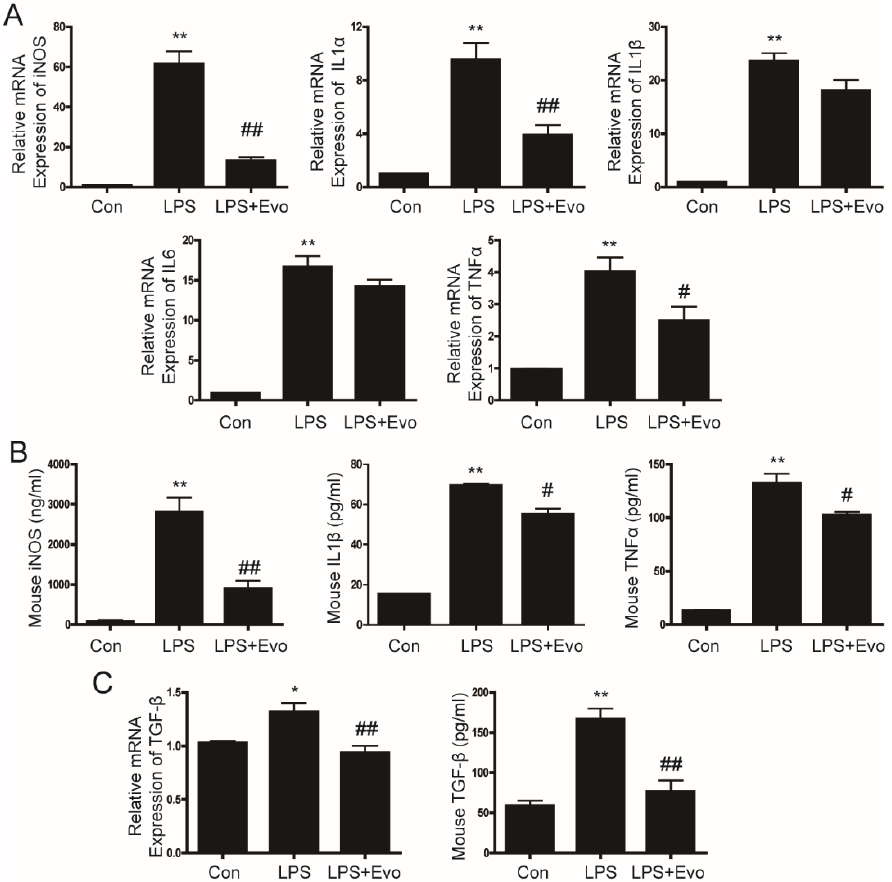
Figure 2. The inhibitory effect of evogliptin on LPS-induced cytokine levels in hepatocytes. Primary hepatocytes were pretreated with LPS for 2 h and then treated with evogliptin for 24 h. ( A ) Repre- sentative real-time RT-PCR analysis of the expression levels of iNOS, IL1 α , IL1 β , IL6, and TNF α . Data are the mean ± SEM. ** p < 0.01 relative to the control, ## p < 0.01 relative to the LPS. ( B ) The production of iNOS and the secretion of IL1 β and TNF α were measured using ELISA. Data are the mean ± SEM. ** p < 0.01 relative to the control, # p < 0.05, ## p < 0.01 relative to LPS. ( C ) TGF- β mRNA was measured by real-time RT-PCR, and TGF- β secretion was measured by ELISA. Data are the mean ± SEM. * p < 0.05, ** p < 0.01 relative to the control, ## p < 0.01 relative to LPS.